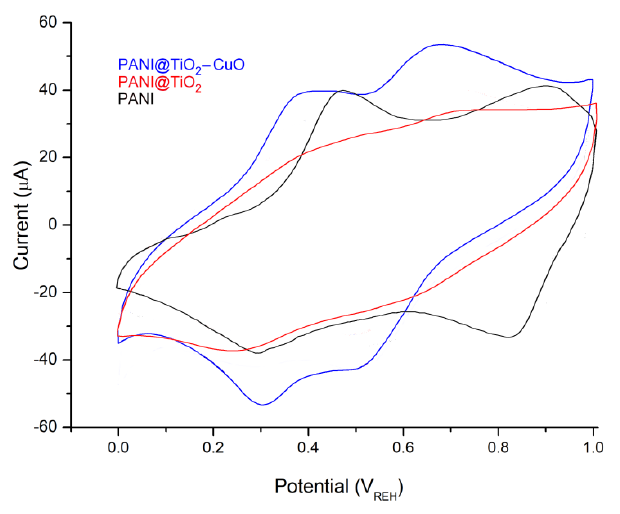
Figure 8. Cyclic voltammograms recorded for a stainless in HCl solution (1M) scan rate 50 mV.s − 1.